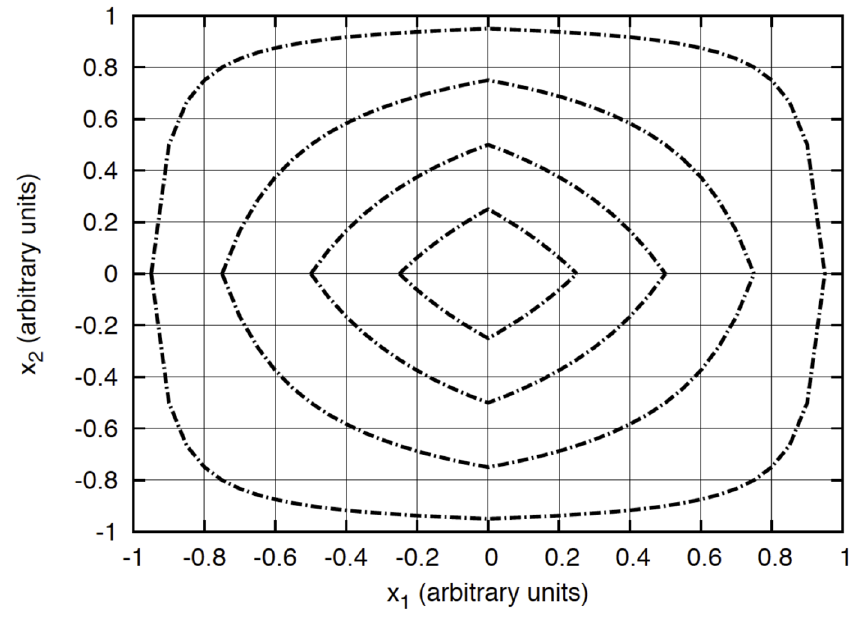
Fig 7. Level curves for the similarity metric used for the case of a two-dimensional